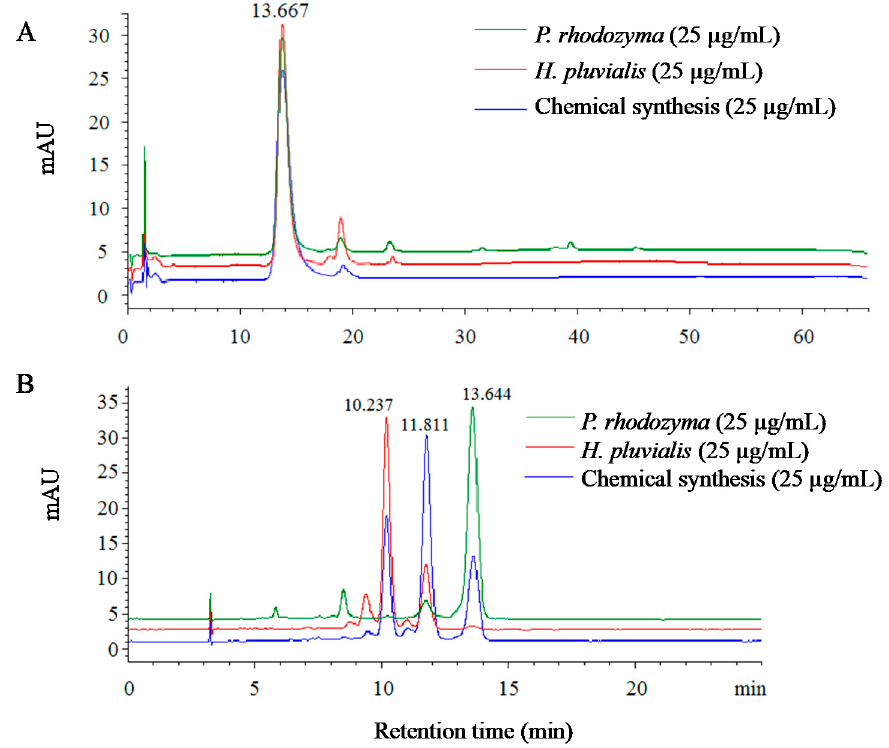
Figure 1. Separation of astaxanthin from P. rhodozyma , H. pluvialis , and chemical synthesis by high-performance liquid chromatography (HPLC) with ZORBAX SB-C18 ( A ) and CHIRALPAK IC ( B ) columns.